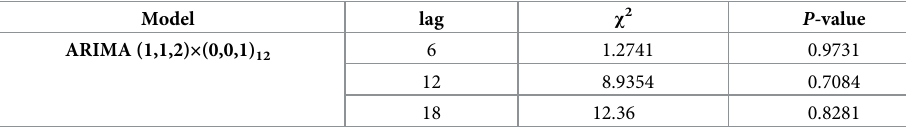
Table 4. White noise test of residuals for ARIMA (1,1,2) × (0,0,1) 12 model.